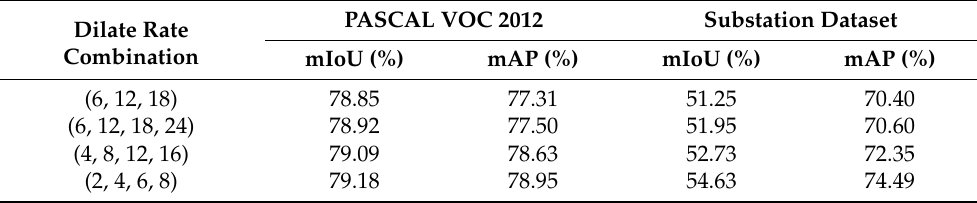
Table 2. Experimental results of mAP and mIoU corresponding to different cavitation rates. Dilate Rate